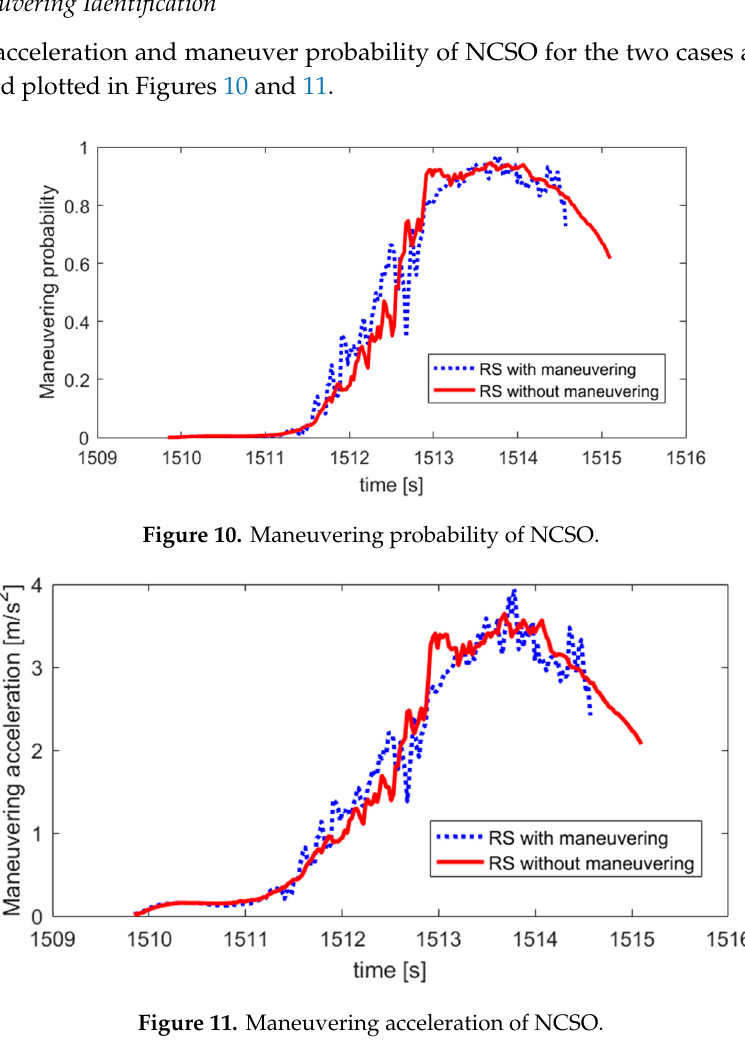
Figure 9. Prediction of collision probability between NCSO and RS.